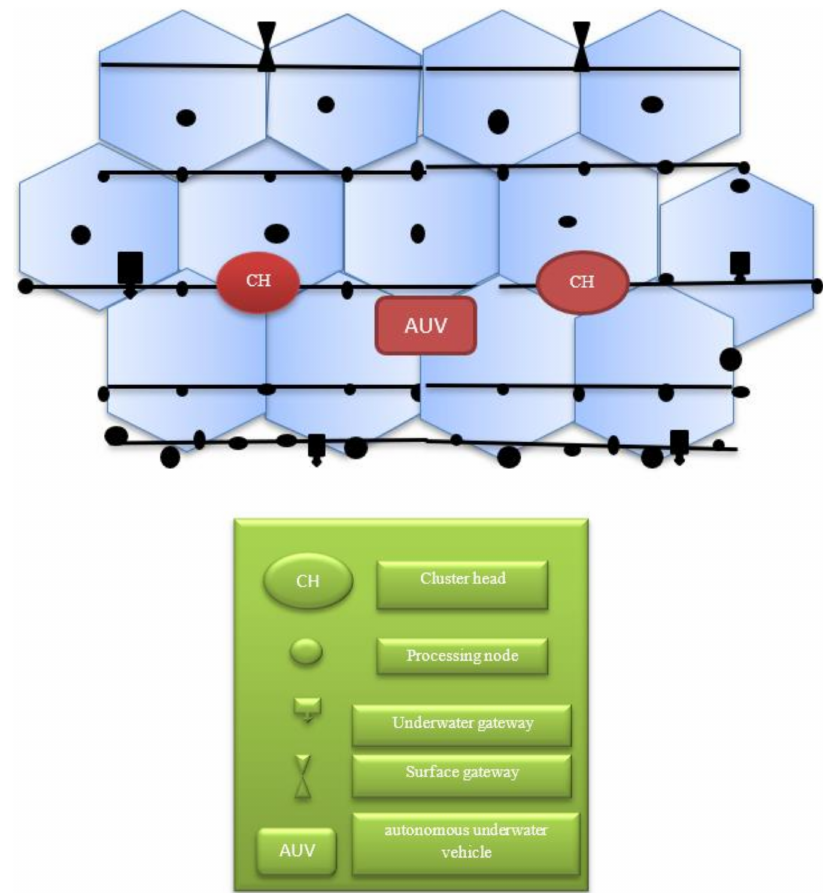
Figure 2. Node deployment in the